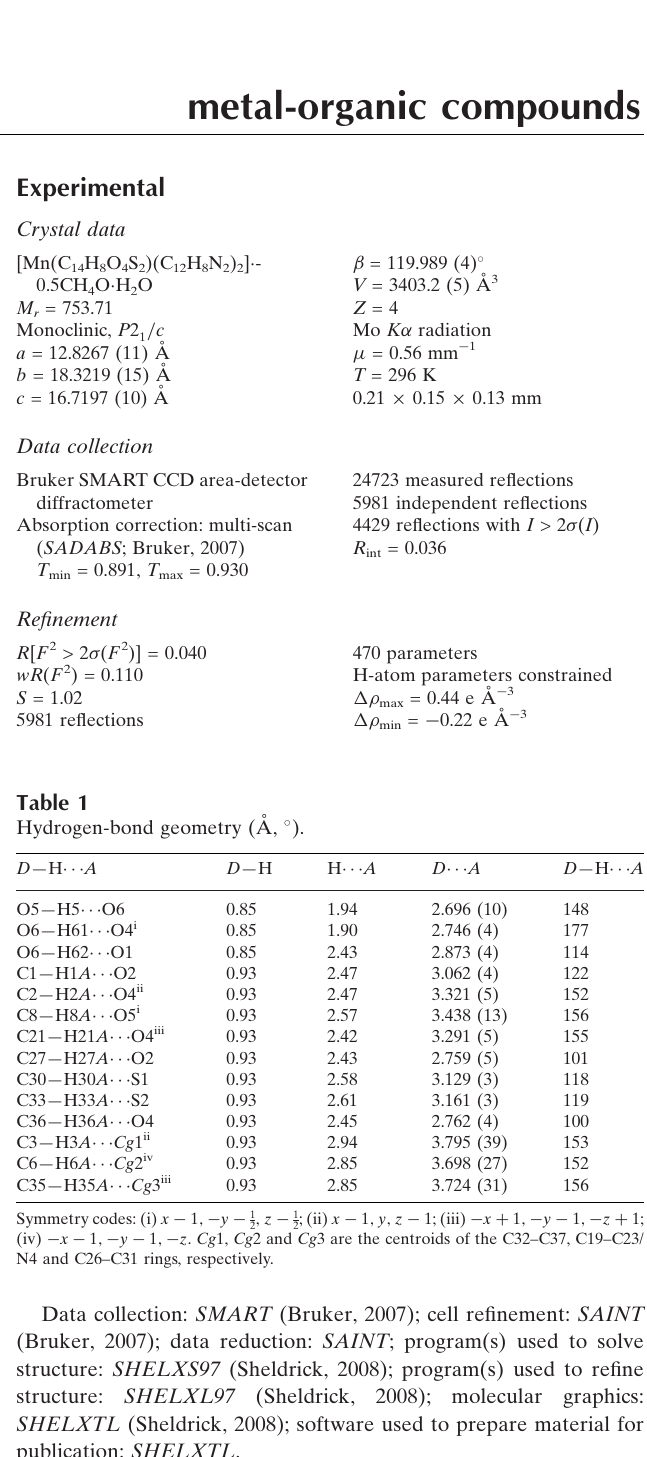
Bruker SMART CCD area-detector diffractometer